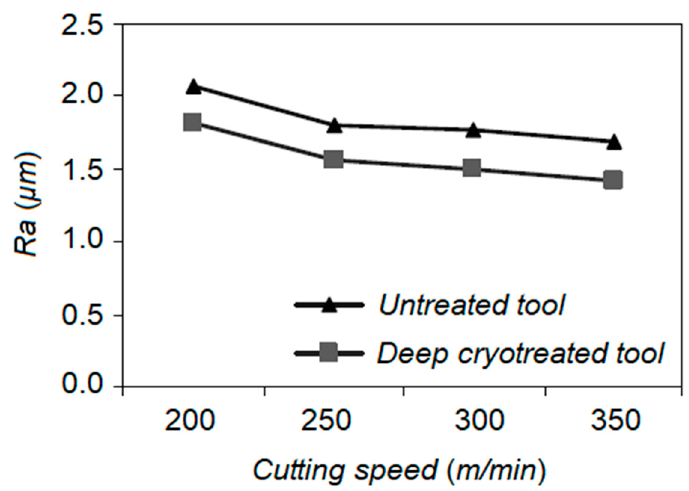
Figure 14. Surface roughness at di ff erent cutting speeds of P-30 insert